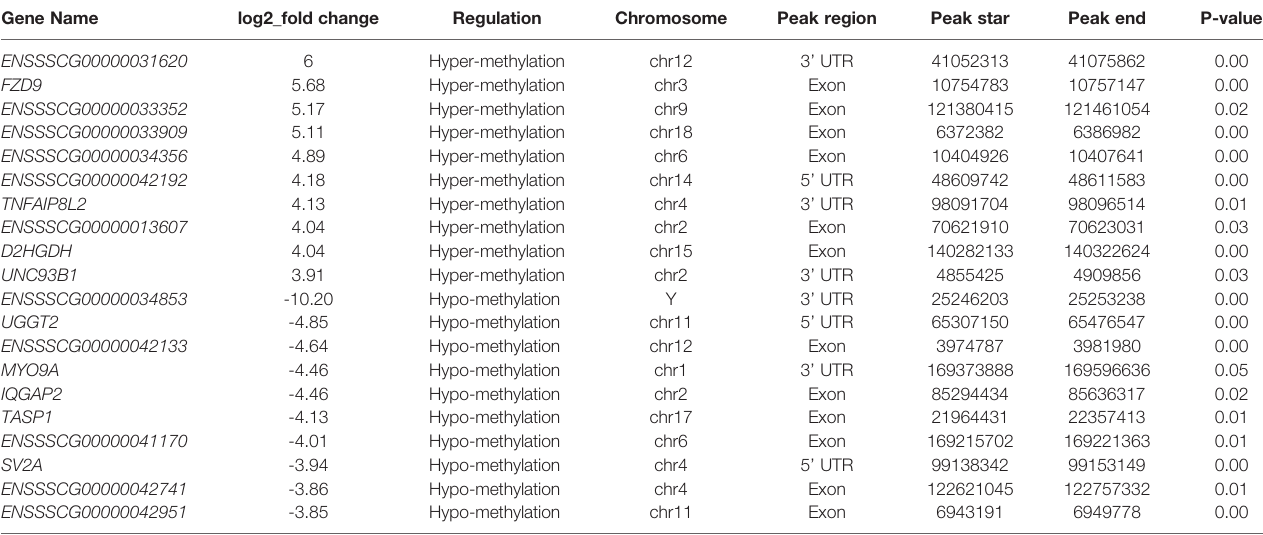
TABLE 1 | The top 20 signi fi cantly differentially expressed m6A peaks.